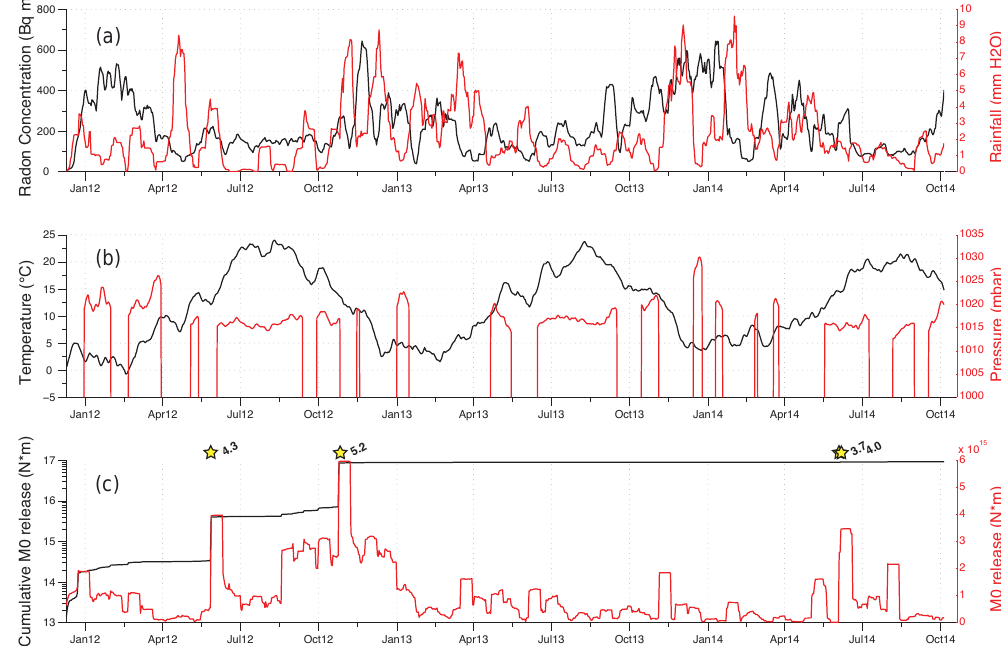
Figure 4. (a) 14-day moving-averaged time series of radon concentration at MMN (black line) and of rainfall (red line). (b) 14-day moving- averaged time series of temperature (black line) and pressure (red line). (c) 14-day moving average of cumulative seismic moment release (black line, in logarithmic scale) and of seismic moment release (red line). Yellow stars represent the occurrences of the main earthquakes of the